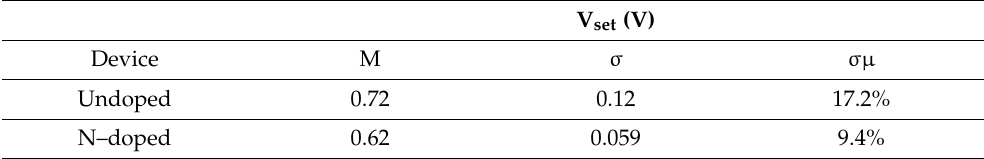
Table 2. Statistical Distribution of Set Voltages Obtained With 300 DC Switching